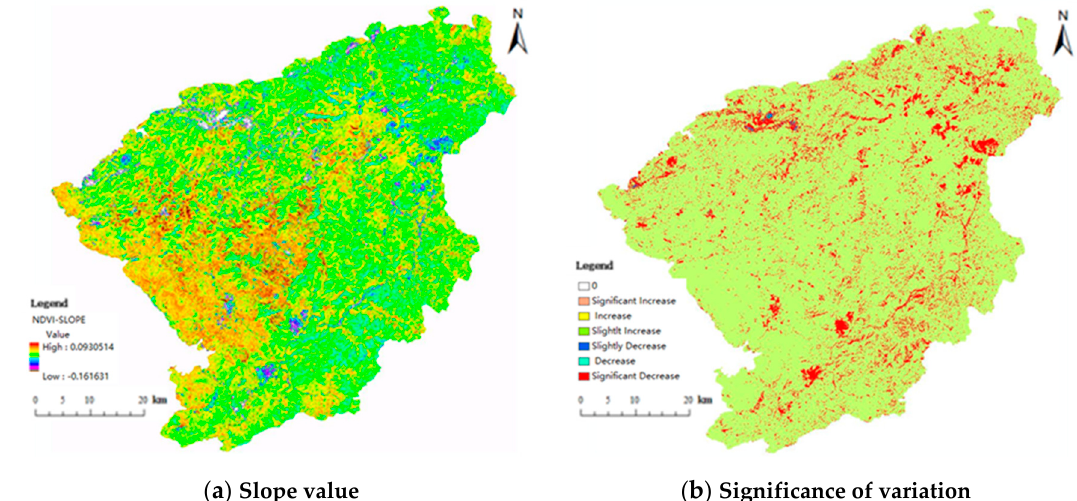
Figure 8. The spatial distribution of the variation trend of the NDVI value from 1987–2018 in